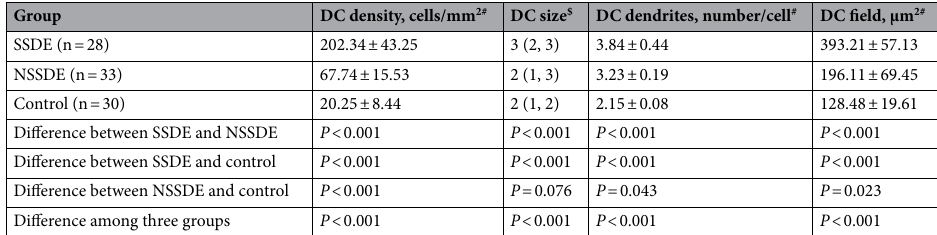
Table 2. The in vivo confocal microscopy parameters for dendritic cell among three groups. DC dendritic cell, SSDE Sjogren’s syndrome dry eye, NSSDE non-Sjogren’s syndrome dry eye; # Mean ± standard deviation; $ Median (25% quantile, 75% quantile).